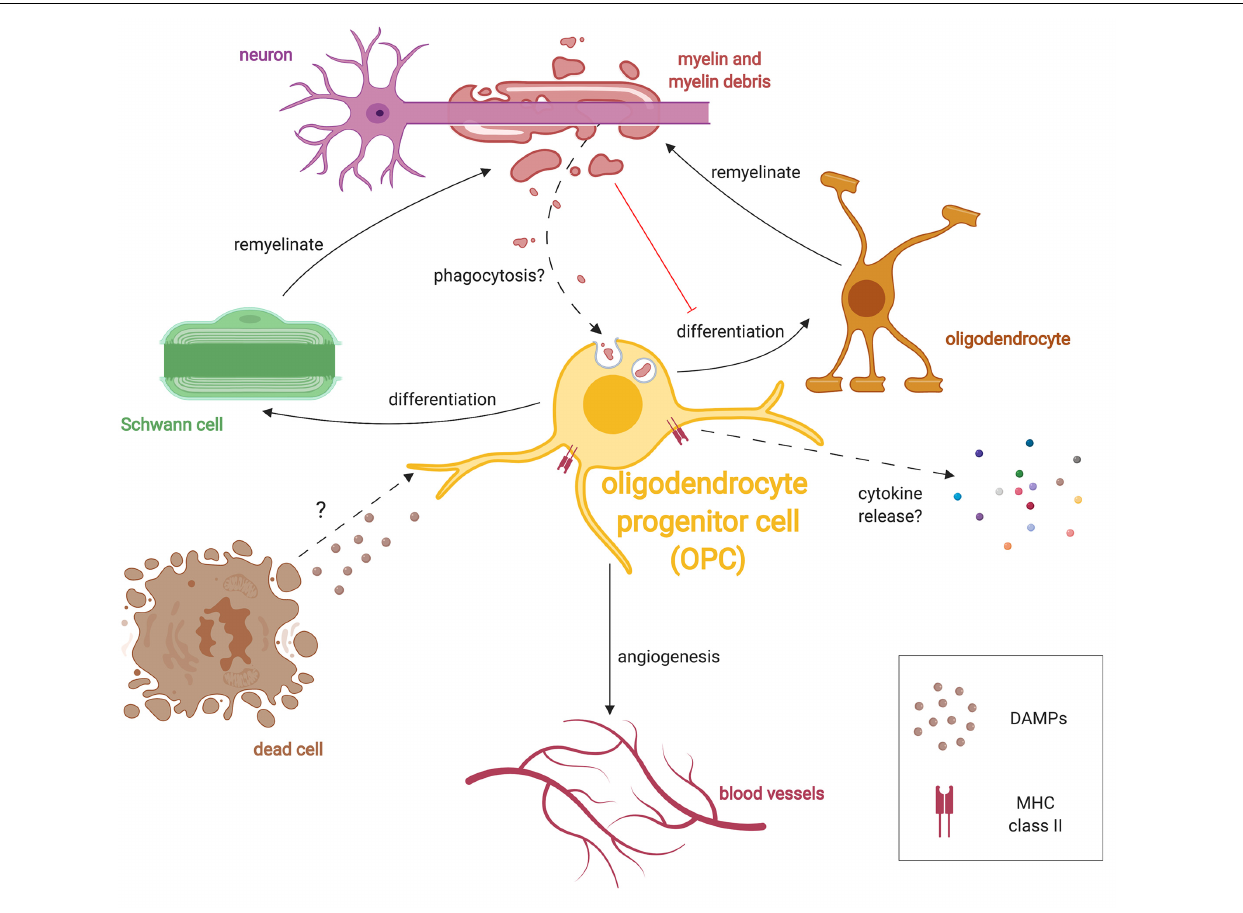
FIGURE 3 | Multiple roles of OPCs during remyelination. After damage, OPCs respond to injury by extending processes, migrating and proliferating following injury presumably in response to unknown DAMPs. OPCs can differentiate into either oligodendrocytes or SCs following demyelination. OPCs also respond to hypoxic conditions and promote angiogenesis. Similar to microglia, OPCs have been shown to phagocytose debris in culture, and may also do so in vivo . Given that myelin debris inhibits OPC lineage progression, phagocytosis of debris may subvert OPCs until debris clearance is completed. OPCs in the diseased state are also known to express the antigen-presenting protein, MHC-II, and presumably release specific cytokines which alter the immune